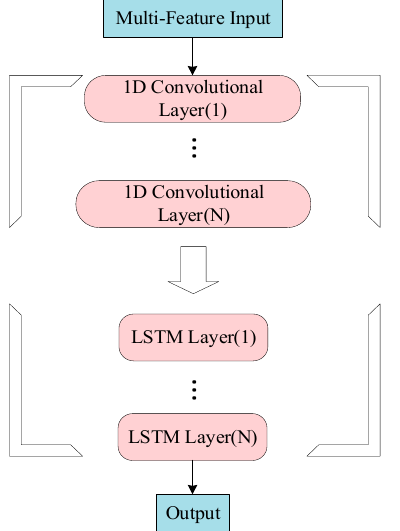
Figure 1. CNN-LSTM combined neural network model.